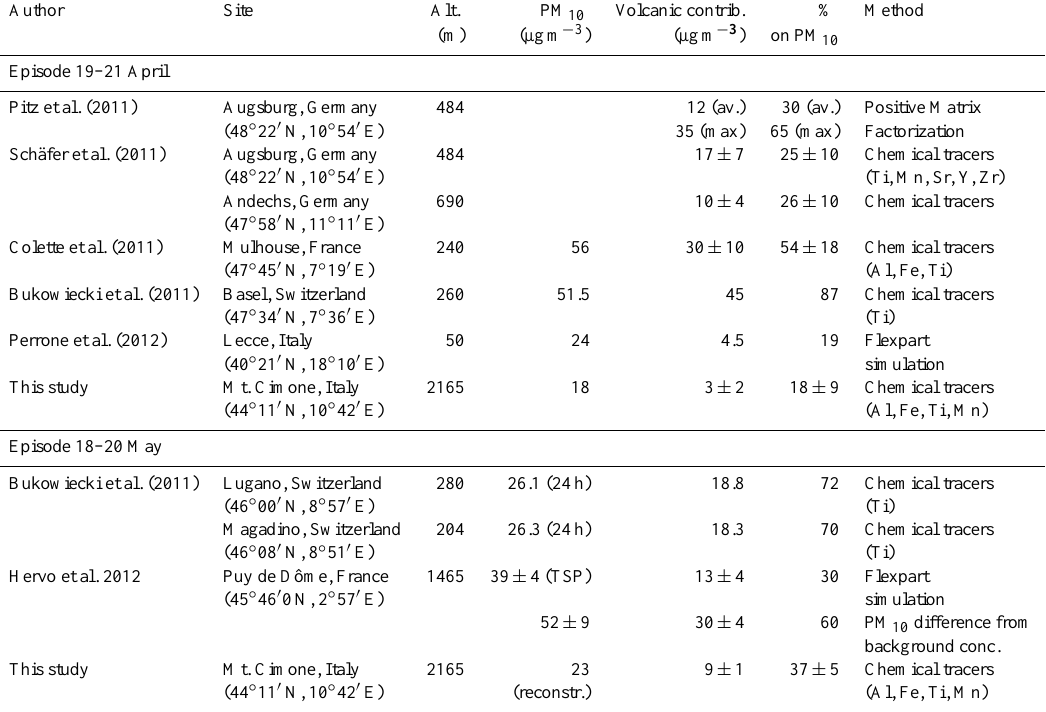
Table 2. Summary of volcanic contributions to total PM 10 observed at different sites in Europe and estimated by the indicated method.